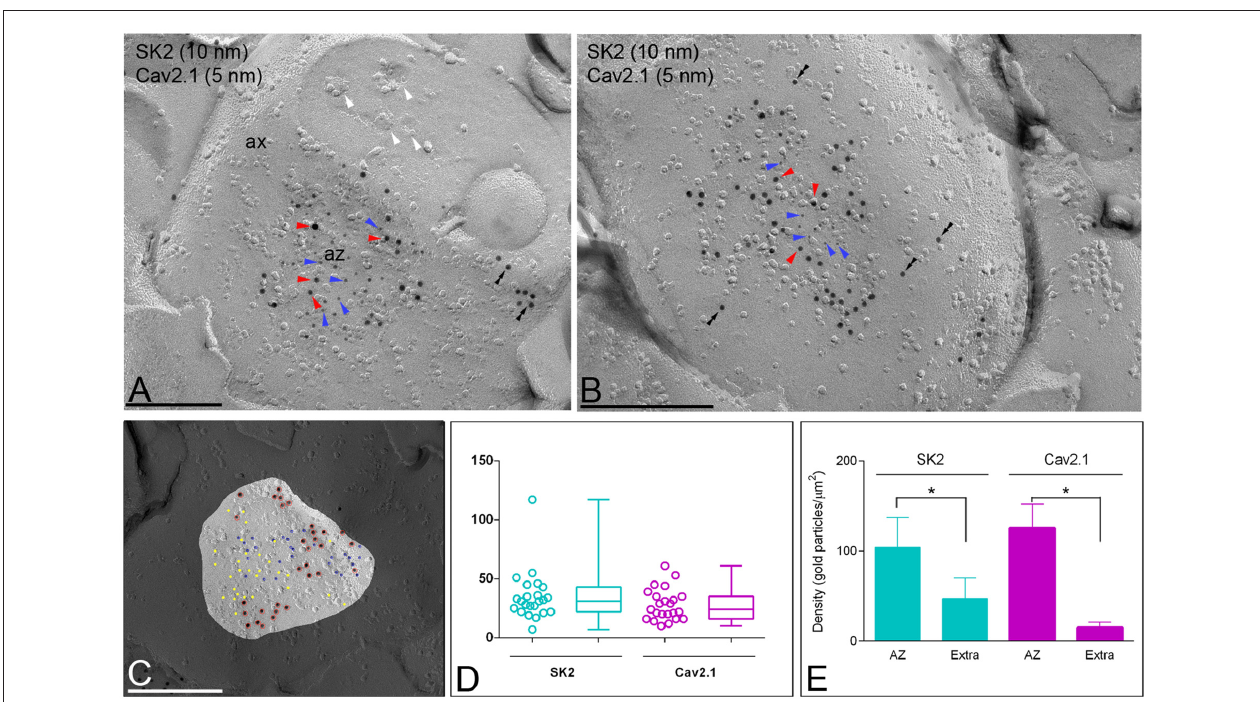
FIGURE 8 | Co-localization of SK2 and Ca V 2.1 channels in the presynaptic AZ of ATs. Electron micrographs obtained in the molecular layer of the cerebellar cortex showing the P-face and cross-fractured face of ATs (ax), which were identified by presence of synaptic vesicles (white arrowheads), as well as active zones (az) recognized by the concave shape of the P-face and the accumulation of IMPs. (A,B) Immunoparticles for SK2 (10 nm particles, red arrowheads) were found within the AZ co-clustering with immunoparticles for Ca V 2.1 (5 nm particles, blue arrowheads). A few immunoparticles for SK2 were also observed along the extrasynaptic site (double arrowheads) of ATs. Scale bars: (A,B) 0.2 µ m. (C) NNDs from SK2 to Ca V 2.1 and in AZs. The NNDs from SK2 to real and simulated Ca V 2.1 immunoparticles were generated using the same numbers of Ca V 2.1 immunoparticles in the same compartment areas, showing no significant differences ( p > 0.05, Kruskal-Wallis test). Insert is an example showing simulation of Cav2.1 immunoparticles in an AZ. Scale bar: 0.2 µ m. (D) A high variability in the number of SK2 (range: 3–21) and Ca V 2.1 (range: 4–24) immunoparticles was found at the AZs. Box chart shows 5th, 25th, 75th and 95th percentiles and median (bar). (E) Histogram showing the densities of SK2 and Ca V 2.1 immunoparticles at the AZ and extrasynaptic sites of ATs. The density of both SK2 and Ca V 2.1 immunoparticles was significantly larger at the AZs (SK2 = 104.10 ± 32.87/ µ m 2 ; Ca V 2. 1 = 125.50 ± 26.61/ µ m 2 ) than at extrasynaptic sites (Extra; SK2 = 47.24 ± 22.81/ µ m 2 ; Ca V 2. 1 = 14.95 ± 5.93/ µ m 2 ; Kruskal–Wallis test, pairwise Mann–Whitney U test and Dunns method, ∗ p <